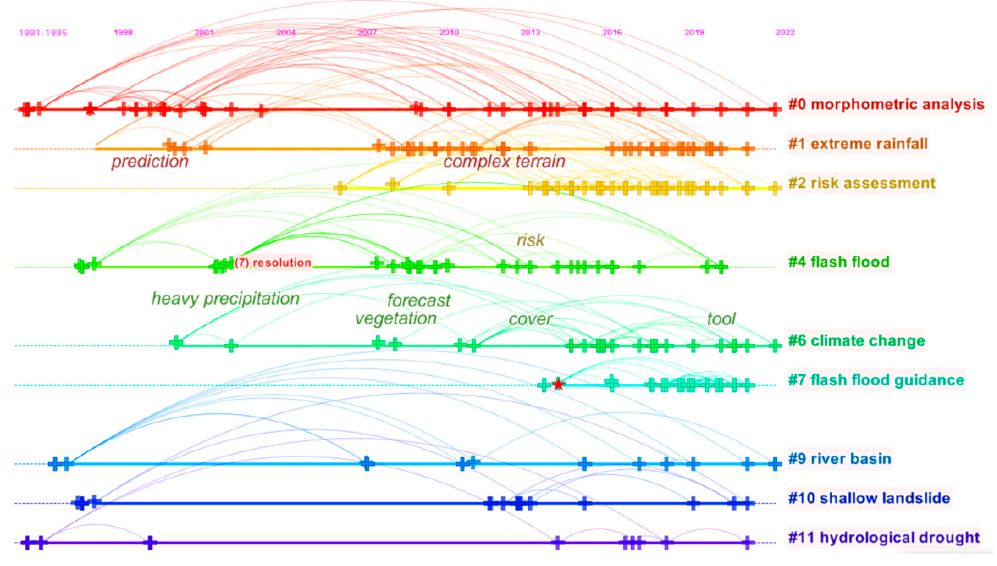
Figure 13. Research trends timeline view.